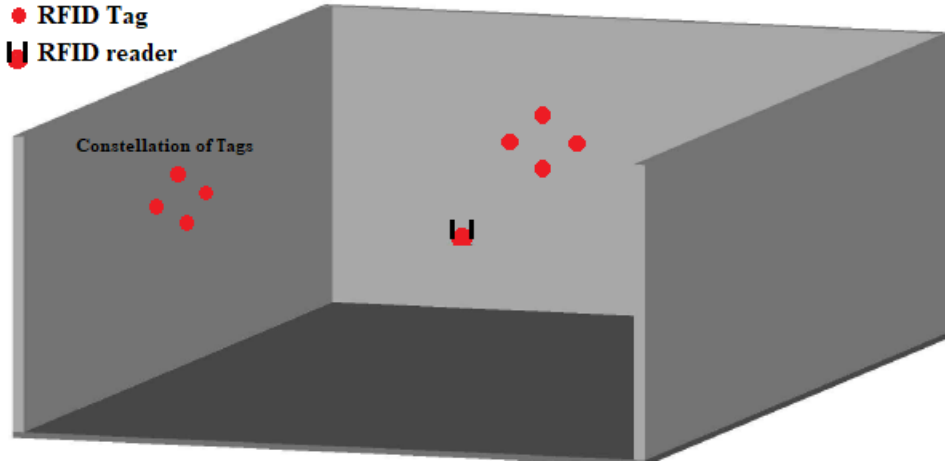
Figure 4. Constellation of four Radio Frequency IDentification (RFID) tags.